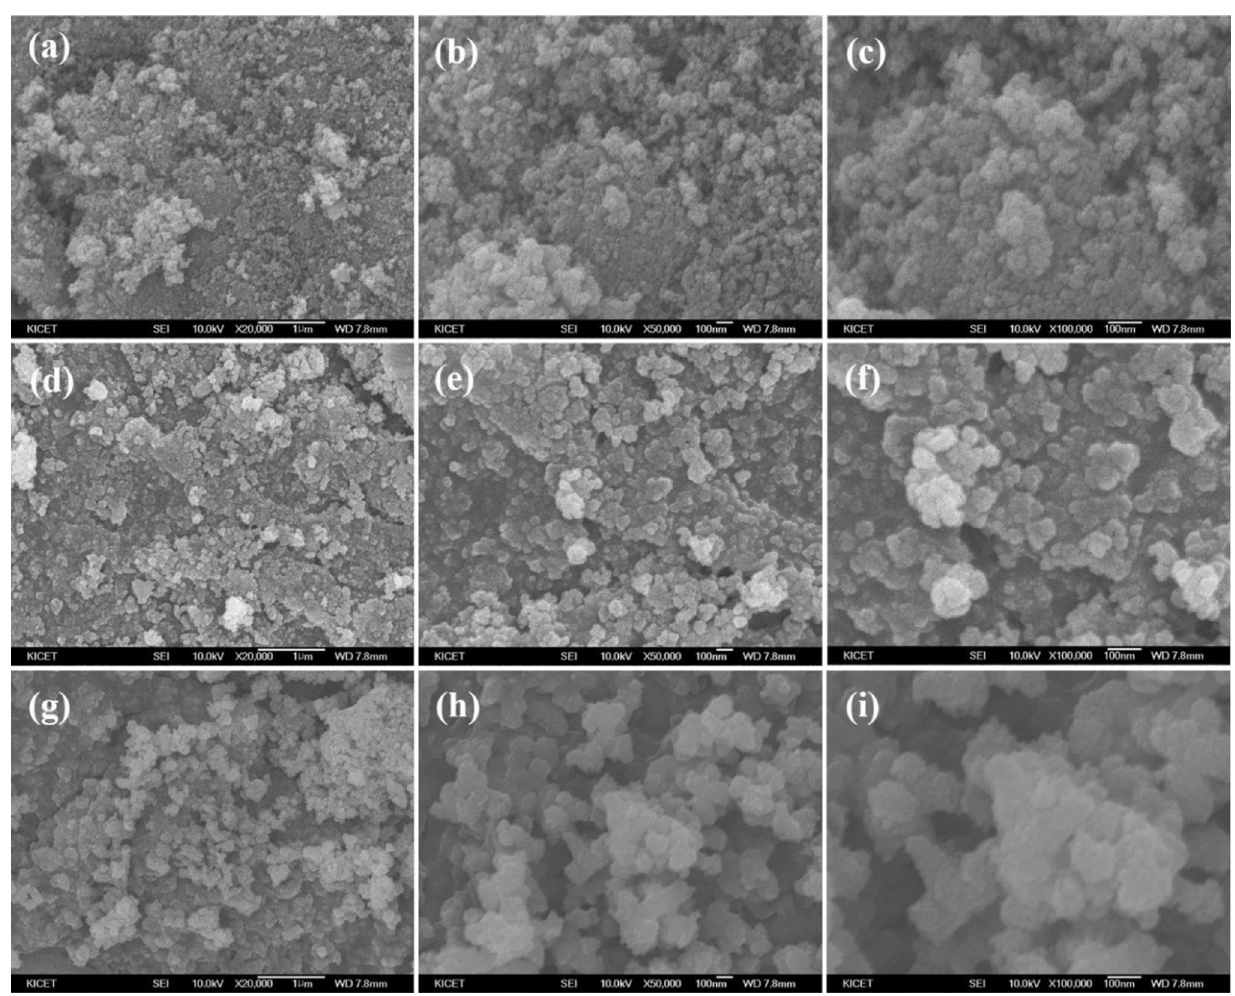
Fig. 1 SEM images of ( a – c ) TiO 2 , ( d – f ) ZnTiO 2 and ( g – i ) CdZnTiO